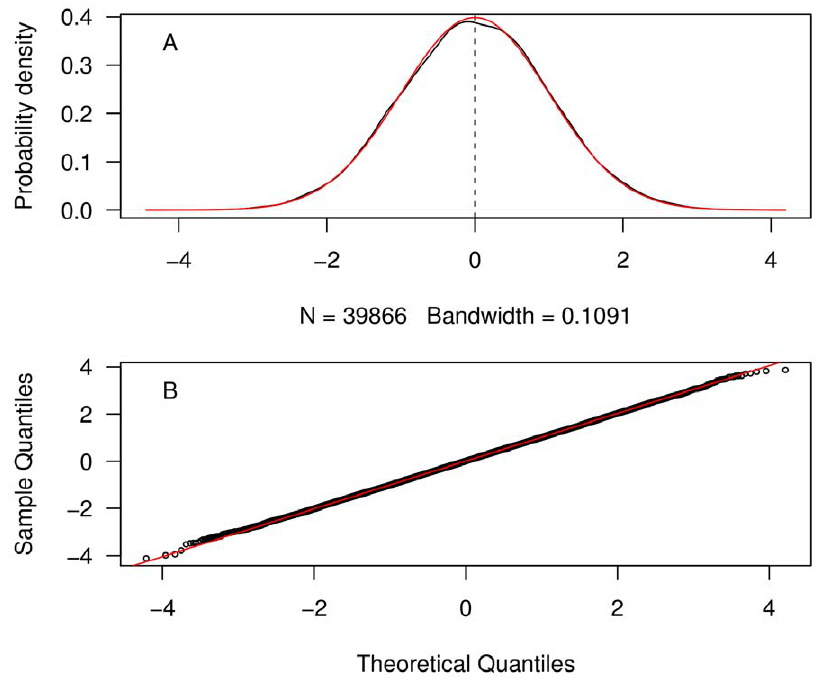
Figure 3. Probability density (A) and ‘‘Q-Q’’ deviations (m) of corrected depth time series from the original, clean, data set (black solid line), and that of normal Gaussian noise (red solid line) introduced into the original time series ( m ~ 0 , s ~ 1 m) (B).